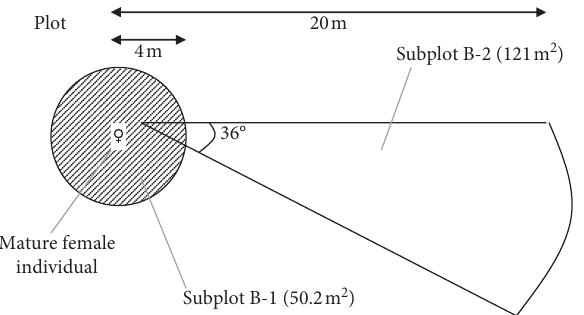
Figure 3: Sampling units for regeneration assessment around female trees in Dodola categories: open areas and shaded areas. Seedlings, which